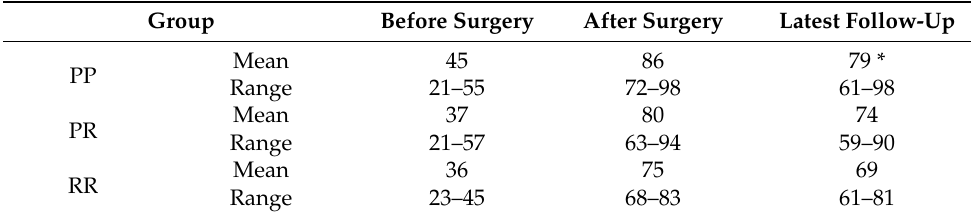
Table 2. Mean JSSF RA foot and ankle scale in three groups.